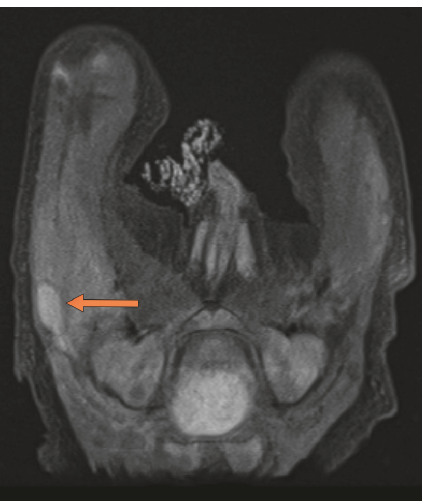
Figure 1: MRI image axial cut demonstrating deep subcutaneous fluid collection with peripheral rim enhancement (arrow) concern- ing for soft tissue